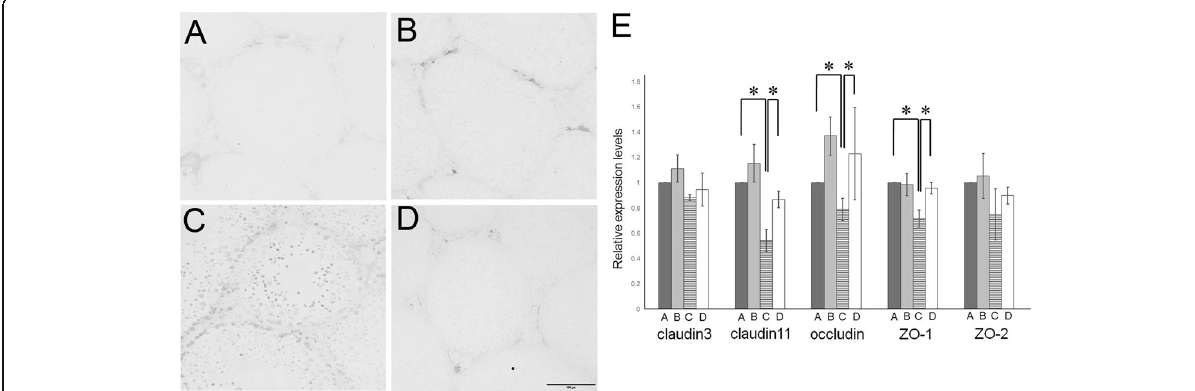
Fig. 5 Serum anti-germ cell antibody levels and testes tight junction markers after irradiation and TJ107 treatment. Diluted sera obtained from Group A a , Group B b , Group C c and Group D d was reacted with Normal frozen sections of seminiferous tubules which was followed by incubation with HRP-conjugated anti-mouse IgG. Bar = 100 μ m. e Changes in the mRNA levels of tight-junction associated markers ( claudin3 , claudin11 , occludin , ZO1 , and ZO2 ) in the mouse testes of each group at 120 days. Calculation of Relative mRNA intensity was done and the expression in the control group for each point was set to 1. The data are presented as mean ± standard deviation ( n = 10). Asterisks indicate p <